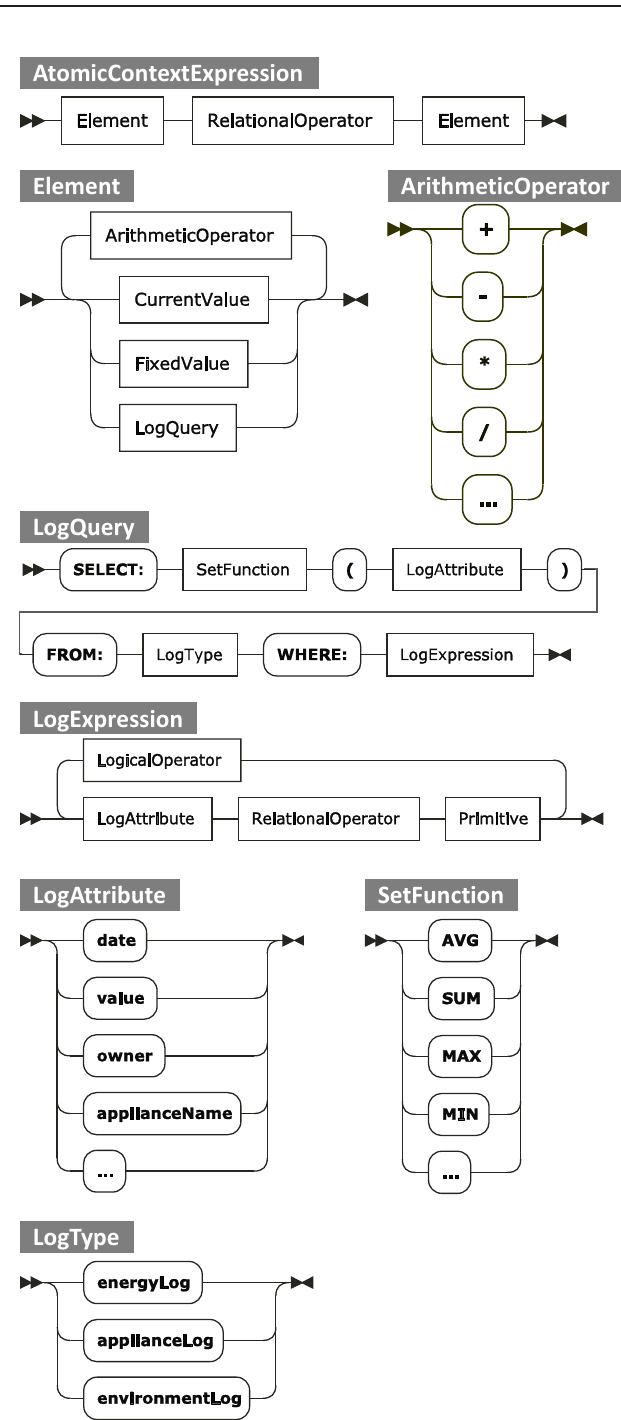
Figure 2. Syntax diagram of context expression (extended